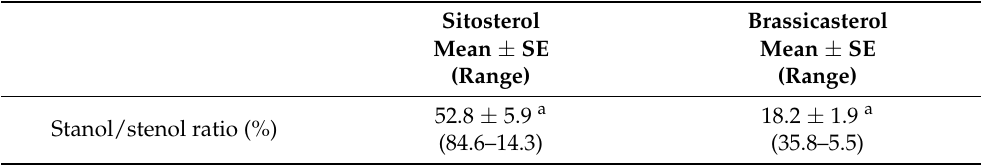
Table 2. Stanol/stenol ratio of sitosterol and brassicasterol in sediment samples collected in the Canadian